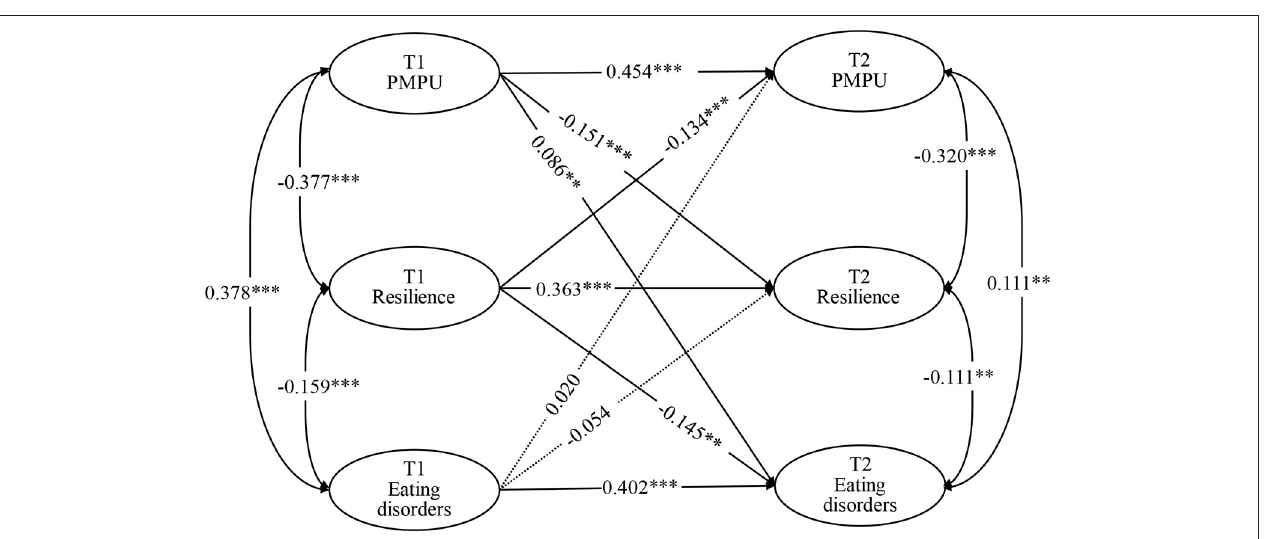
FIGURE 1 | Cross-lagged model for PMPU, resilience, and eating disorders at two time points. ** P < 0.01, *** P < 0.001.